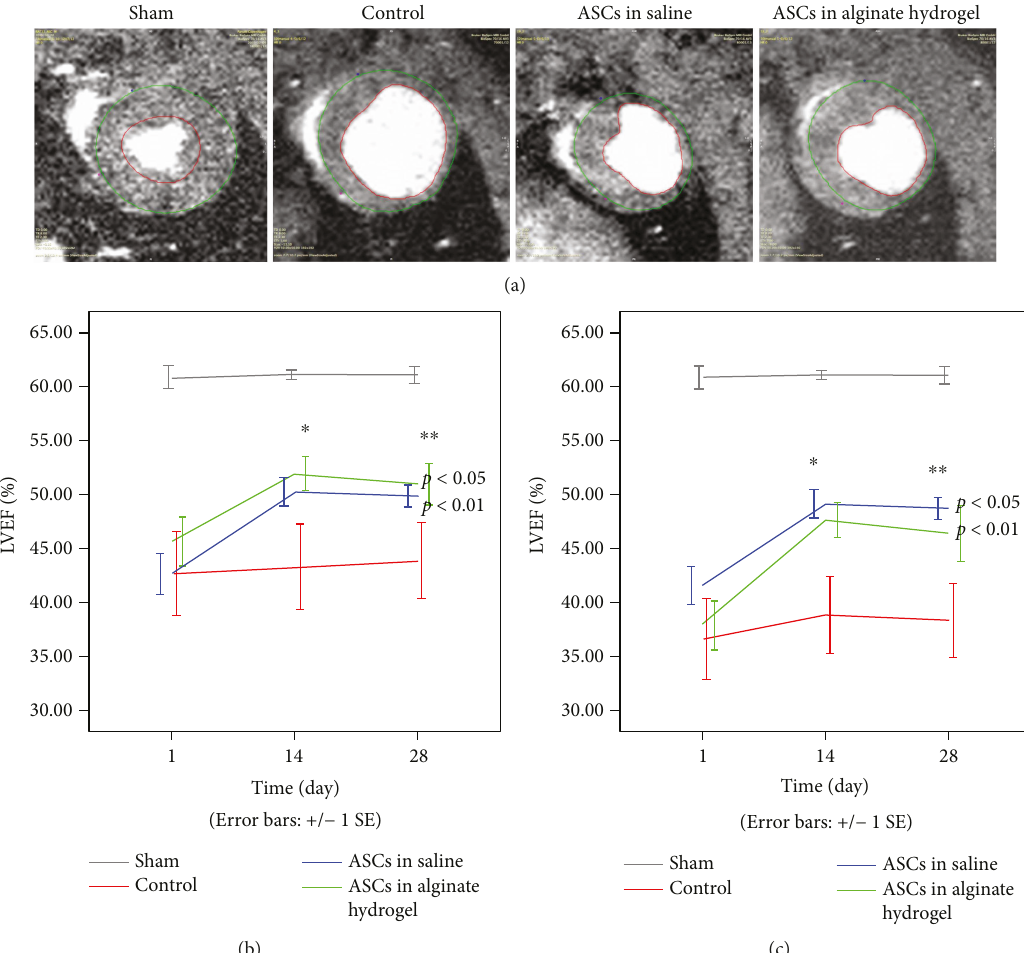
Figure 3: Cardiac pump function. (a) Cine image analysis of hearts from each group in systole. Endocardial (red) and epicardial (green) contours. Black arrow denotes papillary muscles in the sham group. (b) Results for left ventricular ejection fraction (LVEF) (total n = 38 ) and (c) LVEF results when excluding rats with > 50% LVEF at day 1 (total n = 29 ). ∗ denotes signi fi cant di ff erence from baseline ( ∗ p < 0 05 ; ∗∗ p < 0 01 ). Inserted p values denote di ff erence between ASC treatment groups and control group at day 28. ASC: adipose- derived stromal